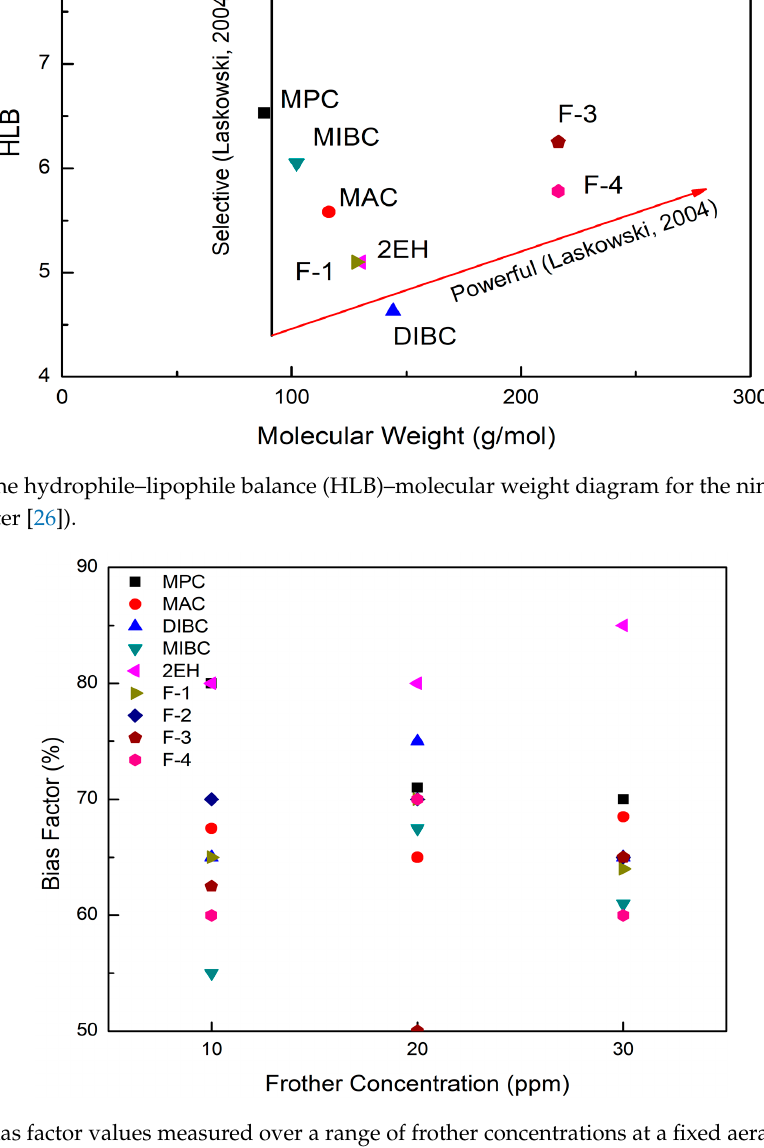
Figure 6. Air fractions measured as a function of concentration in the column at a fixed aeration rate for each of the nine frother types. 3.3. Column Flotation Performance Evaluation The effects of frother type and frother concentration on the separation performances achieved when treating ultrafine coal are shown in Figures 7–10, the data points of which have a standard deviation less than 3 percent in accordance with the replicate tests being performed. MPC was identified as the weakest among all the nine test frothers based on the data presented in Table 4 and